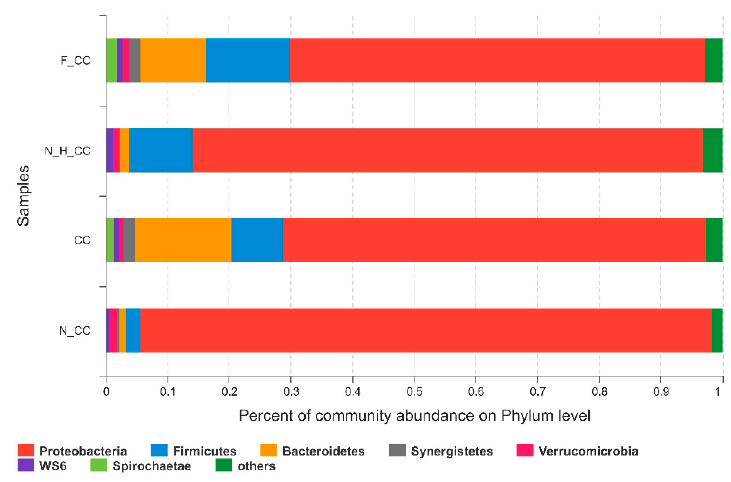
Figure 7. Relative ratio of the dominant bacterial at phylum level in CC, N_CC, N_H_CC, and F_CC.